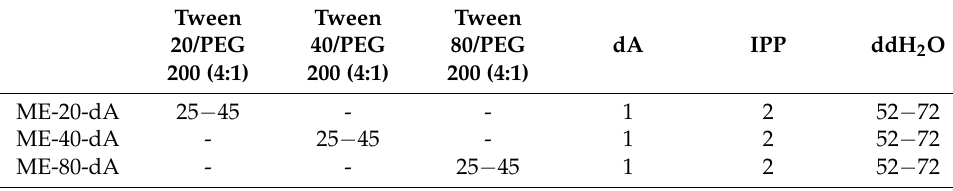
Table 1. Compositions of the deoxyArbutin-containing